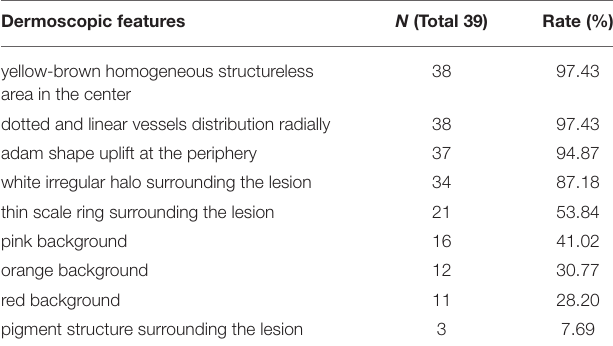
TABLE 1 | Dermoscopic features observed in 39 ARPC patients with relative frequencies.